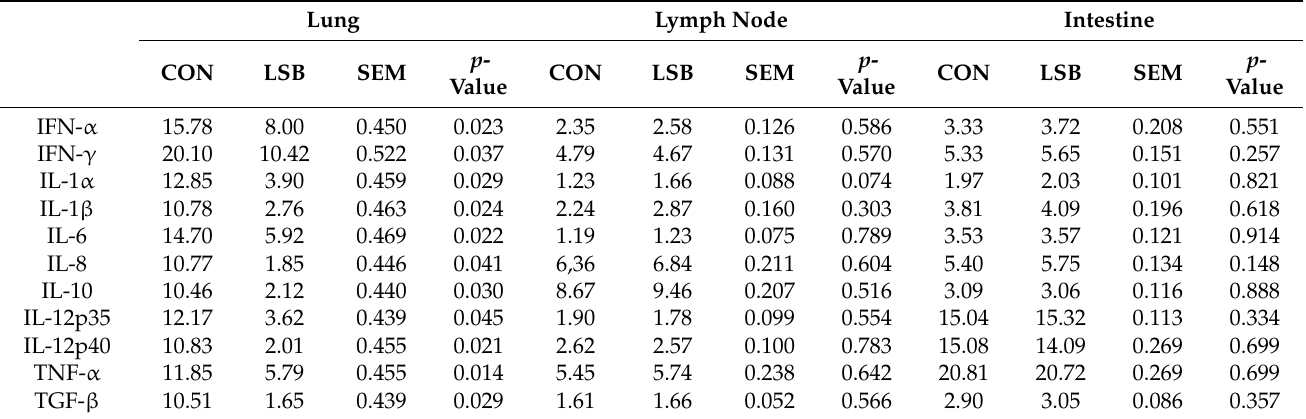
Table 7. Cytokines gene expression results in lung, lymph node and intestine by sow treatment (fold). Lung Lymph Node